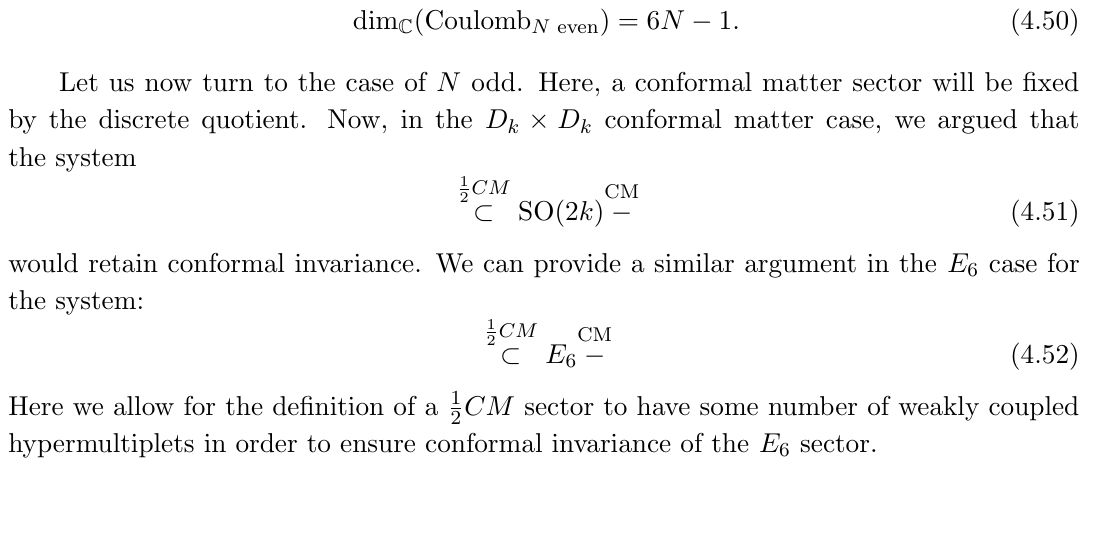
Figure 5 . Quiver theories obtained from a discrete quotient of E on a T 2 with a discrete quotient. On top the unquotiented theories in the tensor branch phase (left) and a(cid:14)ne phase (right). On the bottom the two cases depending on N being even or odd for the two corresponding phases. The segments represents standard N = 2 hypermultiplets, when the 1 = 2 appears on a link it stands for half hypermultiplet. The label \CM" denotes generalized matter coming from compacti(cid:12)cation of the 6D conformal